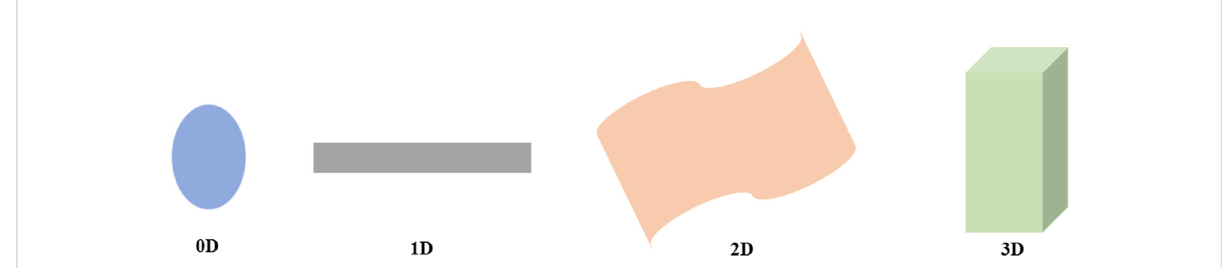
FIGURE 1 Schematic representation of photocatalysts relative to the different